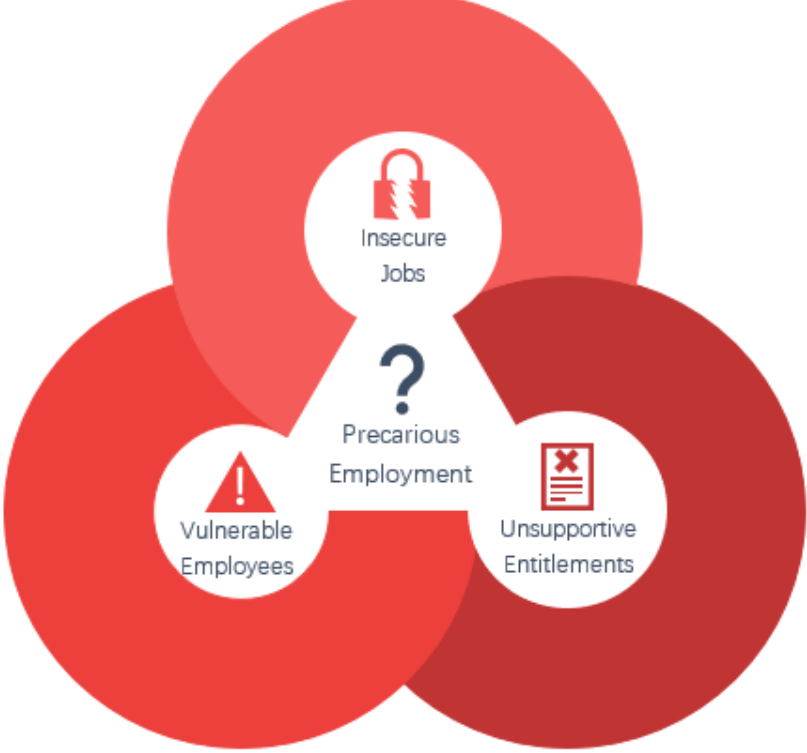
Figure 2. Olsthoorn’s conceptualization of precarious employment. Source: Olsthoorn (2014, p. 426).